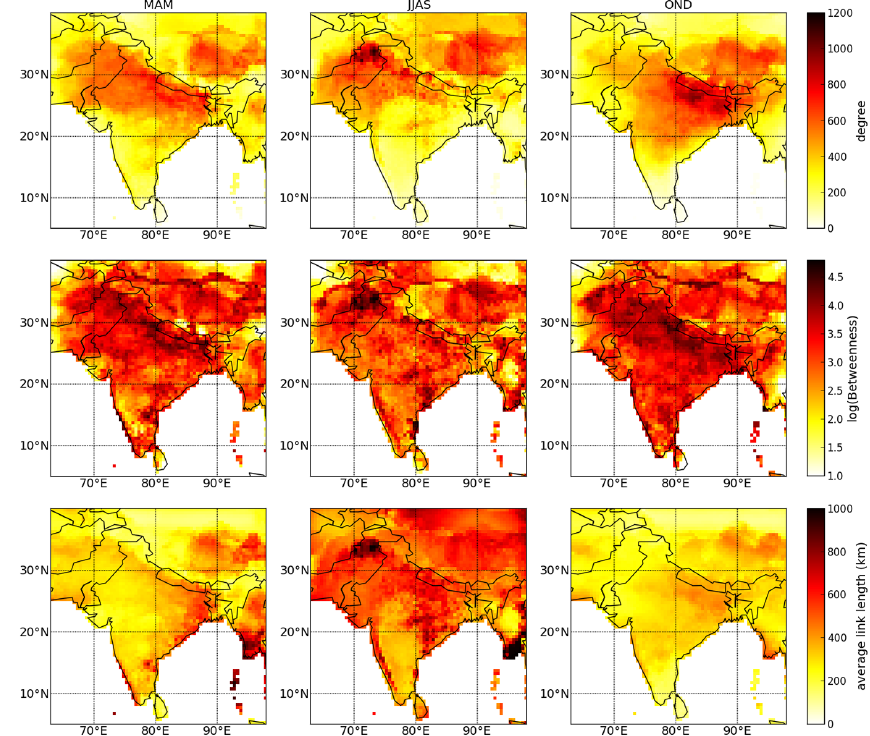
Figure 6. Common network measurements for the three time periods based on the APHRODITE data: pre-monsoon (MAM), monsoon (JJAS), and post-monsoon (OND). From top to bottom: degree, betweenness, average geographical link